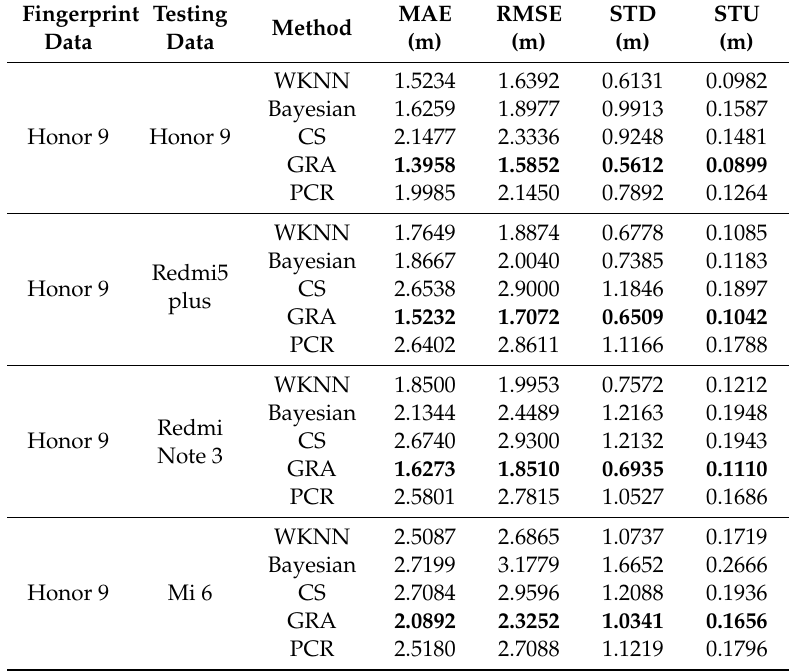
Figure 9. Comparison of positioning performance for different methods under heterogeneous and the same smartphones: Fingerprint data are collected with the Honor 9 smartphone in the offline phase, and the test data are collected with four heterogeneous smartphones in the online phase: ( a ) Honor 9, ( b ) Redmi 5plus, ( c ) Redmi Note 3, and ( d ) Mi 6. Table 4. Positioning errors for different methods under heterogeneous and the same smartphones.